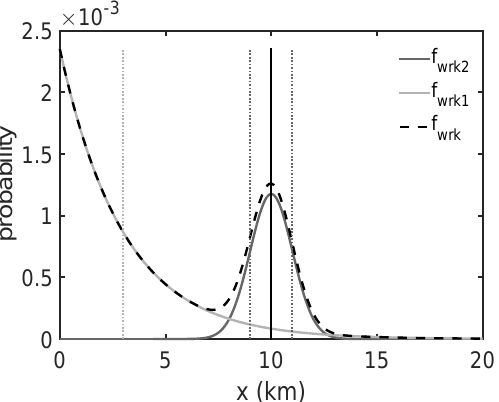
Figure 4. Probability distribution of the location of workplaces (combined f wrk , in the CBD f wrk 1 , and near home location f wrk 2 ) for urban dwellers living 10 km away from CBD. χ CBD (dotted black line) is set to 3 km and σ (dotted gray lines) to 1 km. A grid spacing ∆ x = 10 m is used to create a smooth